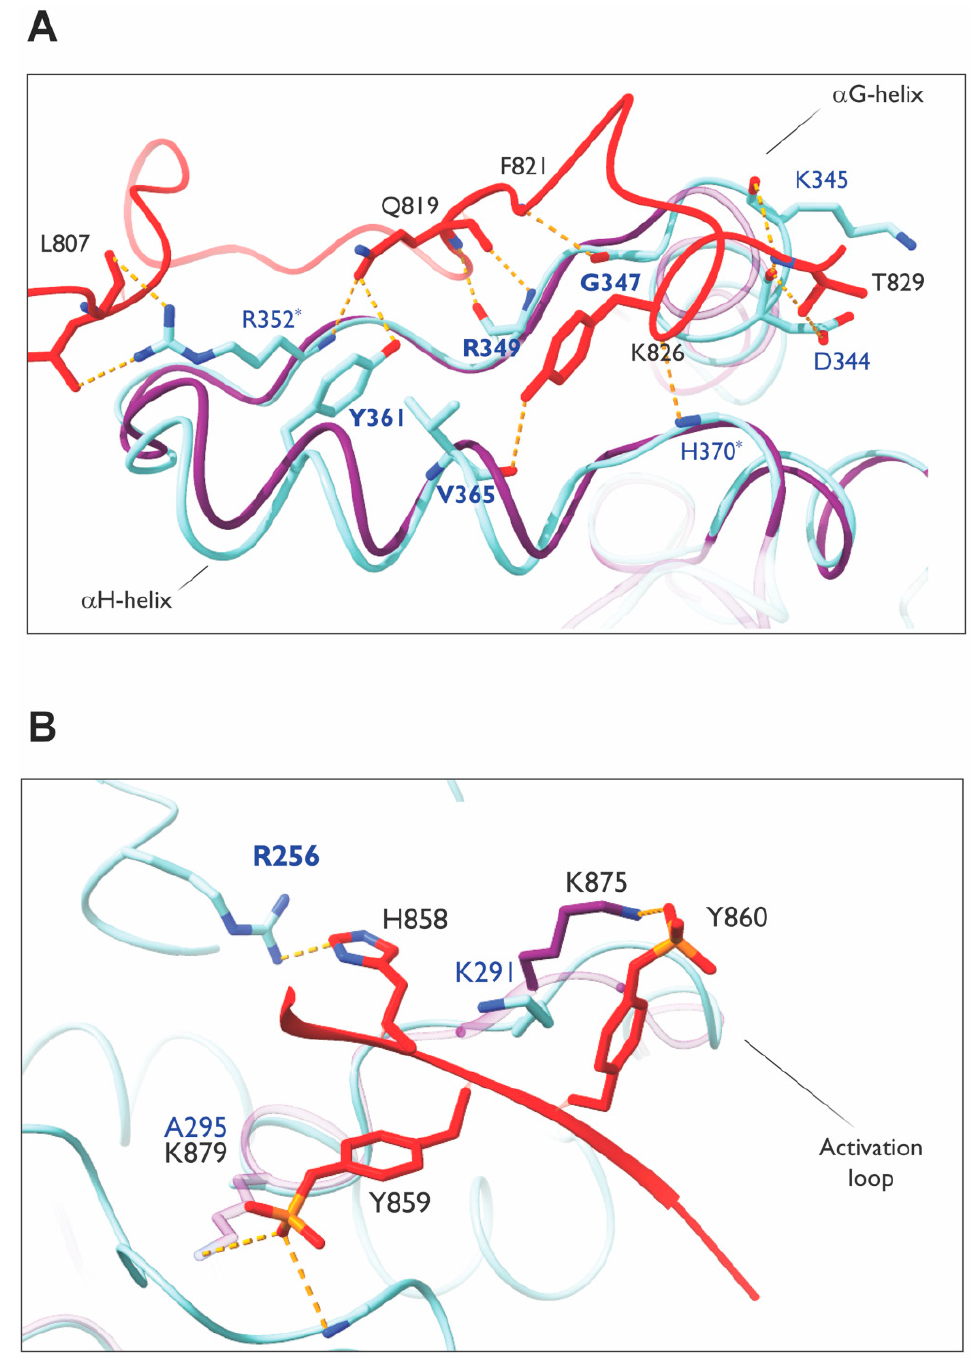
Figure 13. Homology modeling of MHR–Ack1 KD. ( A ) Model showing MHR segment 1 interaction sites with the C-lobe of Ack1 KD. The α H-helix and α G-helix are marked as reference points. Segment 1 of MHR (red) is putatively superimposed on Ack1 KD (light blue) using the crystal structure of EGFR KD (purple) bound to Mig6 (PDB: 4ZJV). The MHR residues are labeled in black; Ack1 KD residues are in navy. The conserved residues between EGFR KD and Ack1 KD are marked in bold. Non-conserved novel interacting partners are marked with an asterisk. ( B ) Segment 2 interaction sites at the substrate binding site. The activation loop is labeled as a reference point. Segment 2 of MHR (red) is superimposed on Ack1 KD (light blue) using the crystal structure of EGFR KD (purple) bound to Mig6 (PDB: 4ZJV). The MHR residues are labeled in black; Ack1 KD residues are in navy. Hydrogen bonds are depicted in yellow dashed lines. Note that a key lysine in EGFR KD that interacts with Mig6 is not conserved in the Ack1 KD.